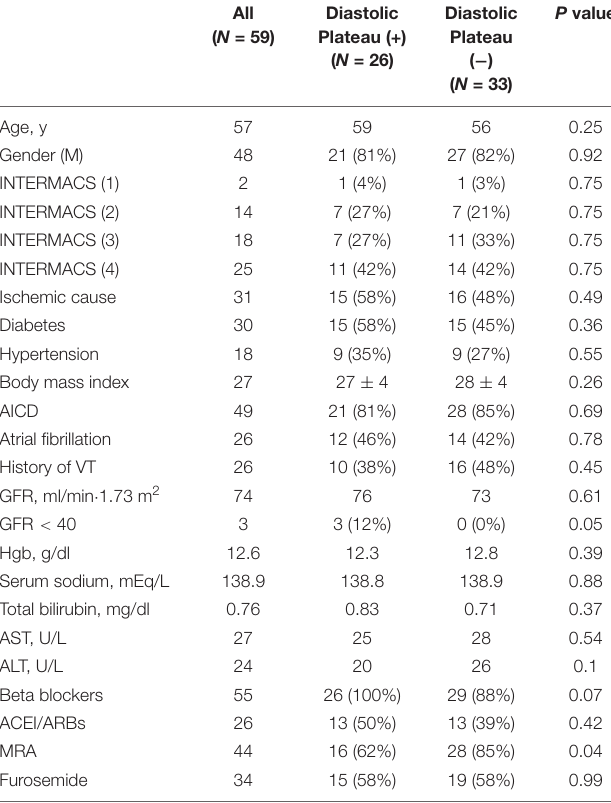
TABLE 1 | Baseline patient